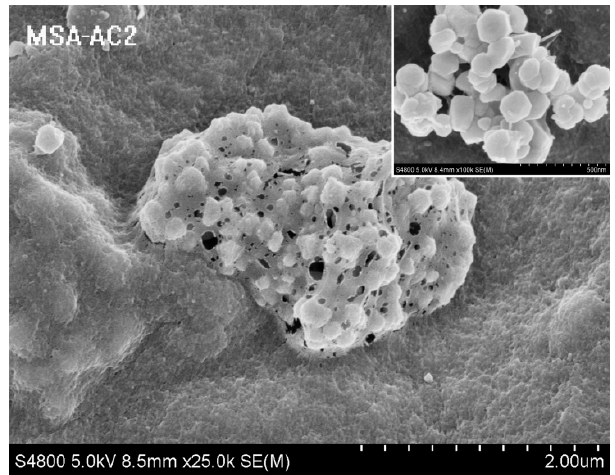
Figure 2. Representative SEM images of SA, AC and MSA-AC2.